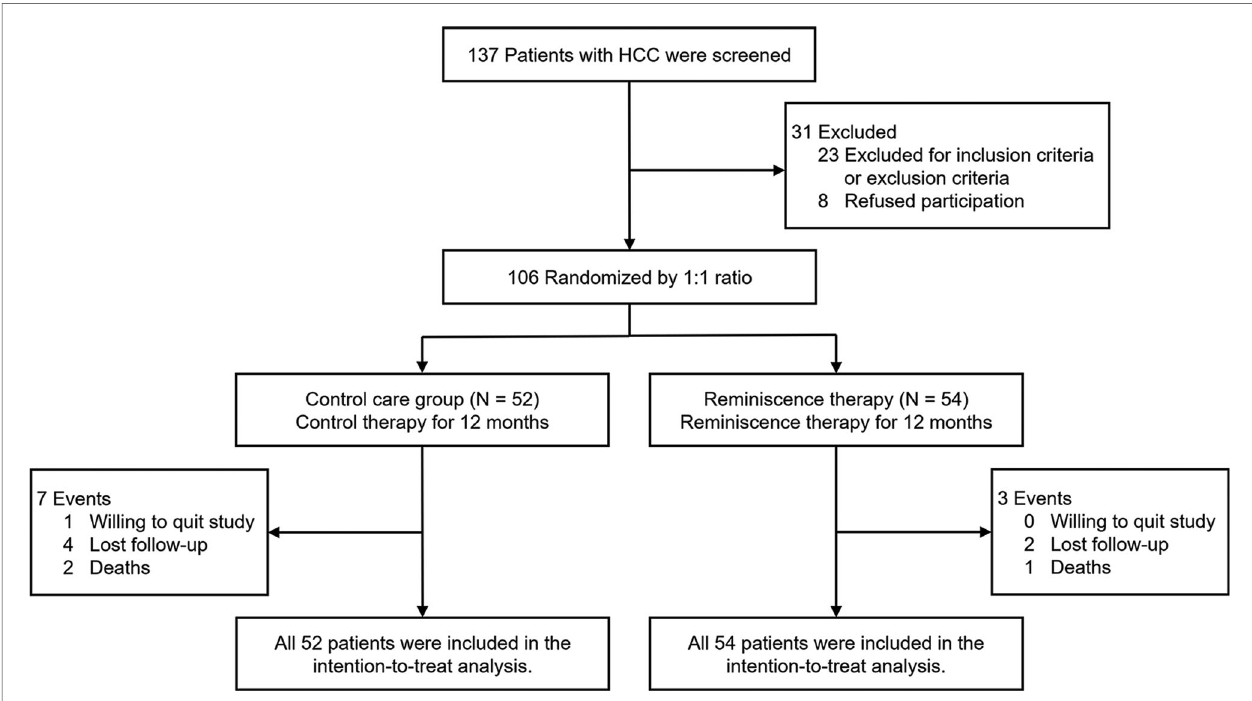
FIGURE 1 | Study fl ow of the current